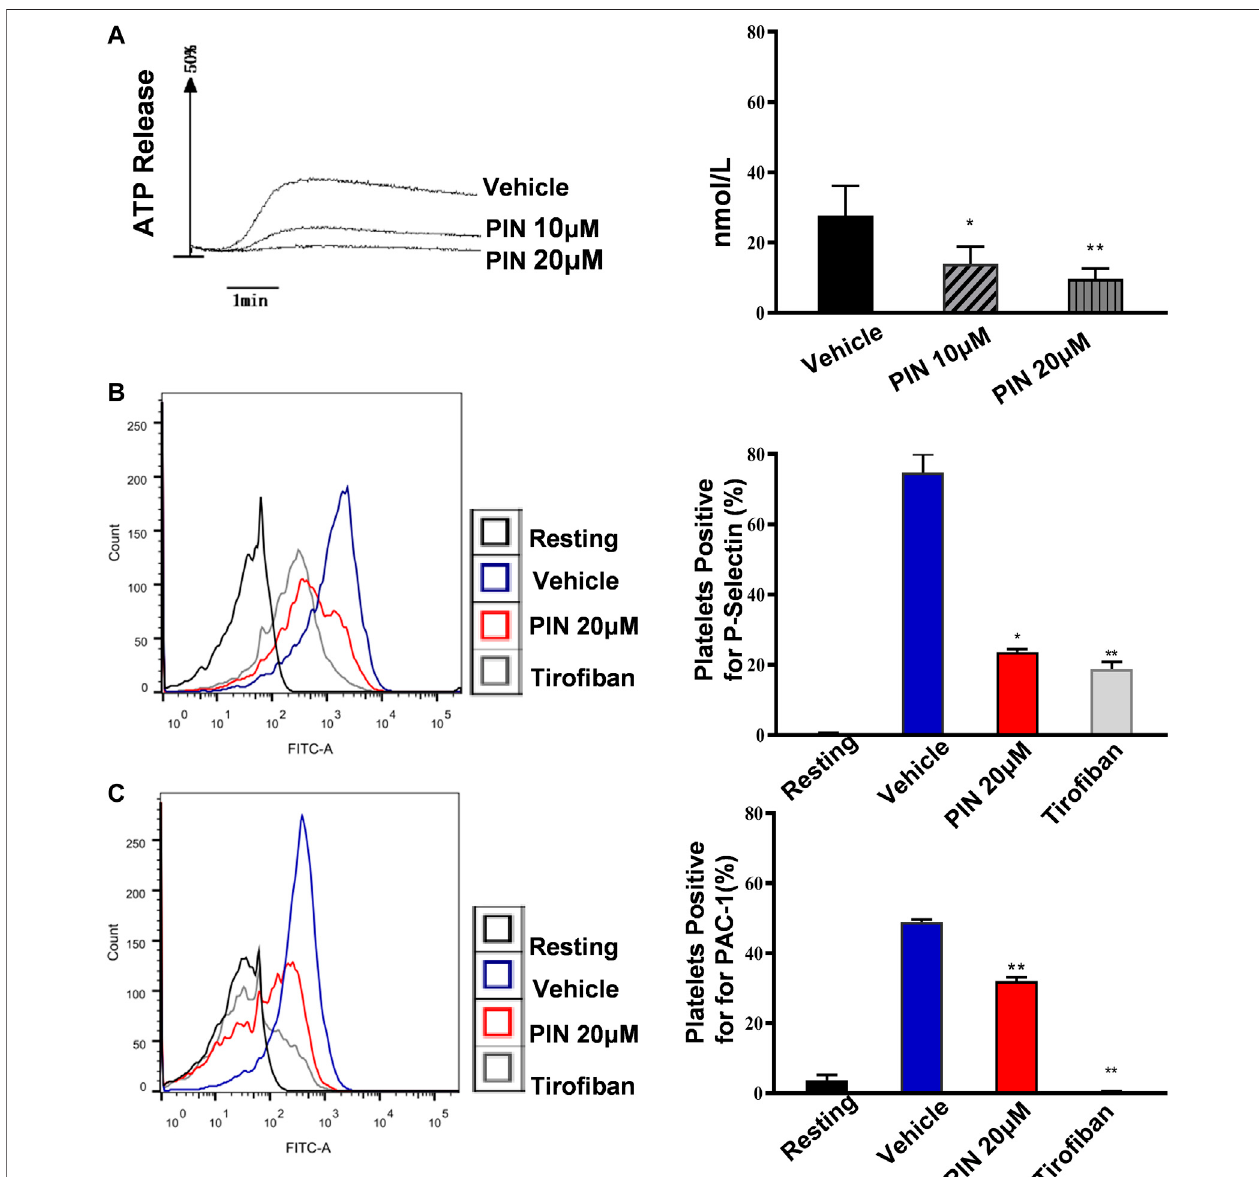
FIGURE2| Pimpinellin inhibited platelet ATPrelease, P-selectin expression and PAC-1. (A) Washed plateletswere treatedwith pimpinellin (10and 20 μ M) at 37 ° C for 5 min and ATP release was measured after stimulation with collagen (1 μ g/ml) using a Lumi-Aggregometer. One-way ANOVA followed by Bonferroni post-hoc analysis of the data. (* p < 0.05, ** p < 0.01; compared to the vehicle group). (B , C) Washed platelets (3.0 × 10 8 /ml) were incubated with vehicle or pimpinellin (20 μ M), Then CRP (1 μ g/ml) was added to stimulate the expression of P-selection (B) and PAC-1 (C) . (resting control, black line; CRP-activated, blue line; pimpinellin 20 μ M, red line; Tiro fi ban, brown line). Detection of P-selection, PAC-1 expression by fl ow cytometry ( n (cid:2) 3). Bar graphs show mean ± SEM ( n (cid:2) 3). * p < 0.05 and ** p < 0.01 compared to the vehicle group.